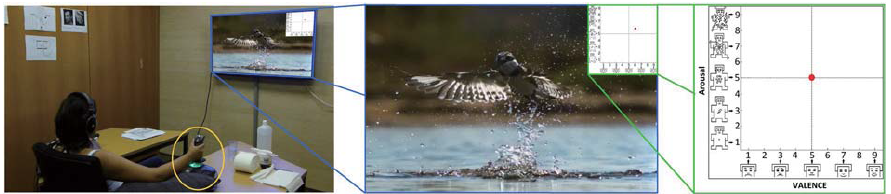
Figure 2. The experiment setup and annotation interface for CASE